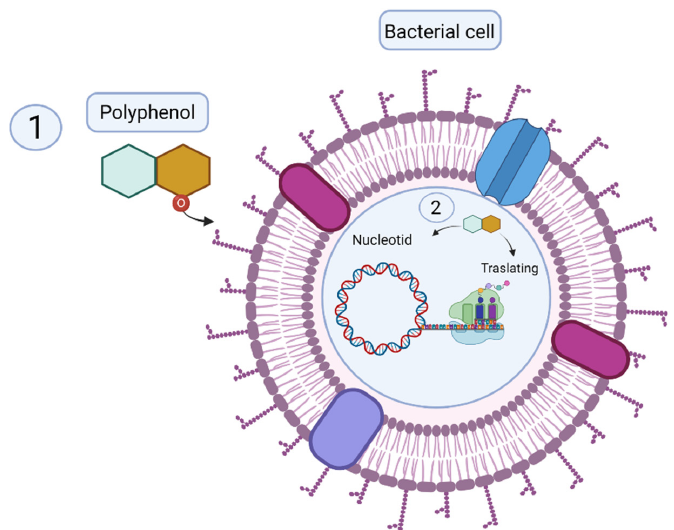
Figure 1. Antimicrobial mechanism of polyphenols. ( 1 ) The polyphenol molecule reacts with the proteins of the cell membrane of bacteria, causing lysis. ( 2 ) Inside the cell, it interferes with the synthesis of DNA and proteins, causing the death of the cell (created with BioRender.com, 3 July 2021).